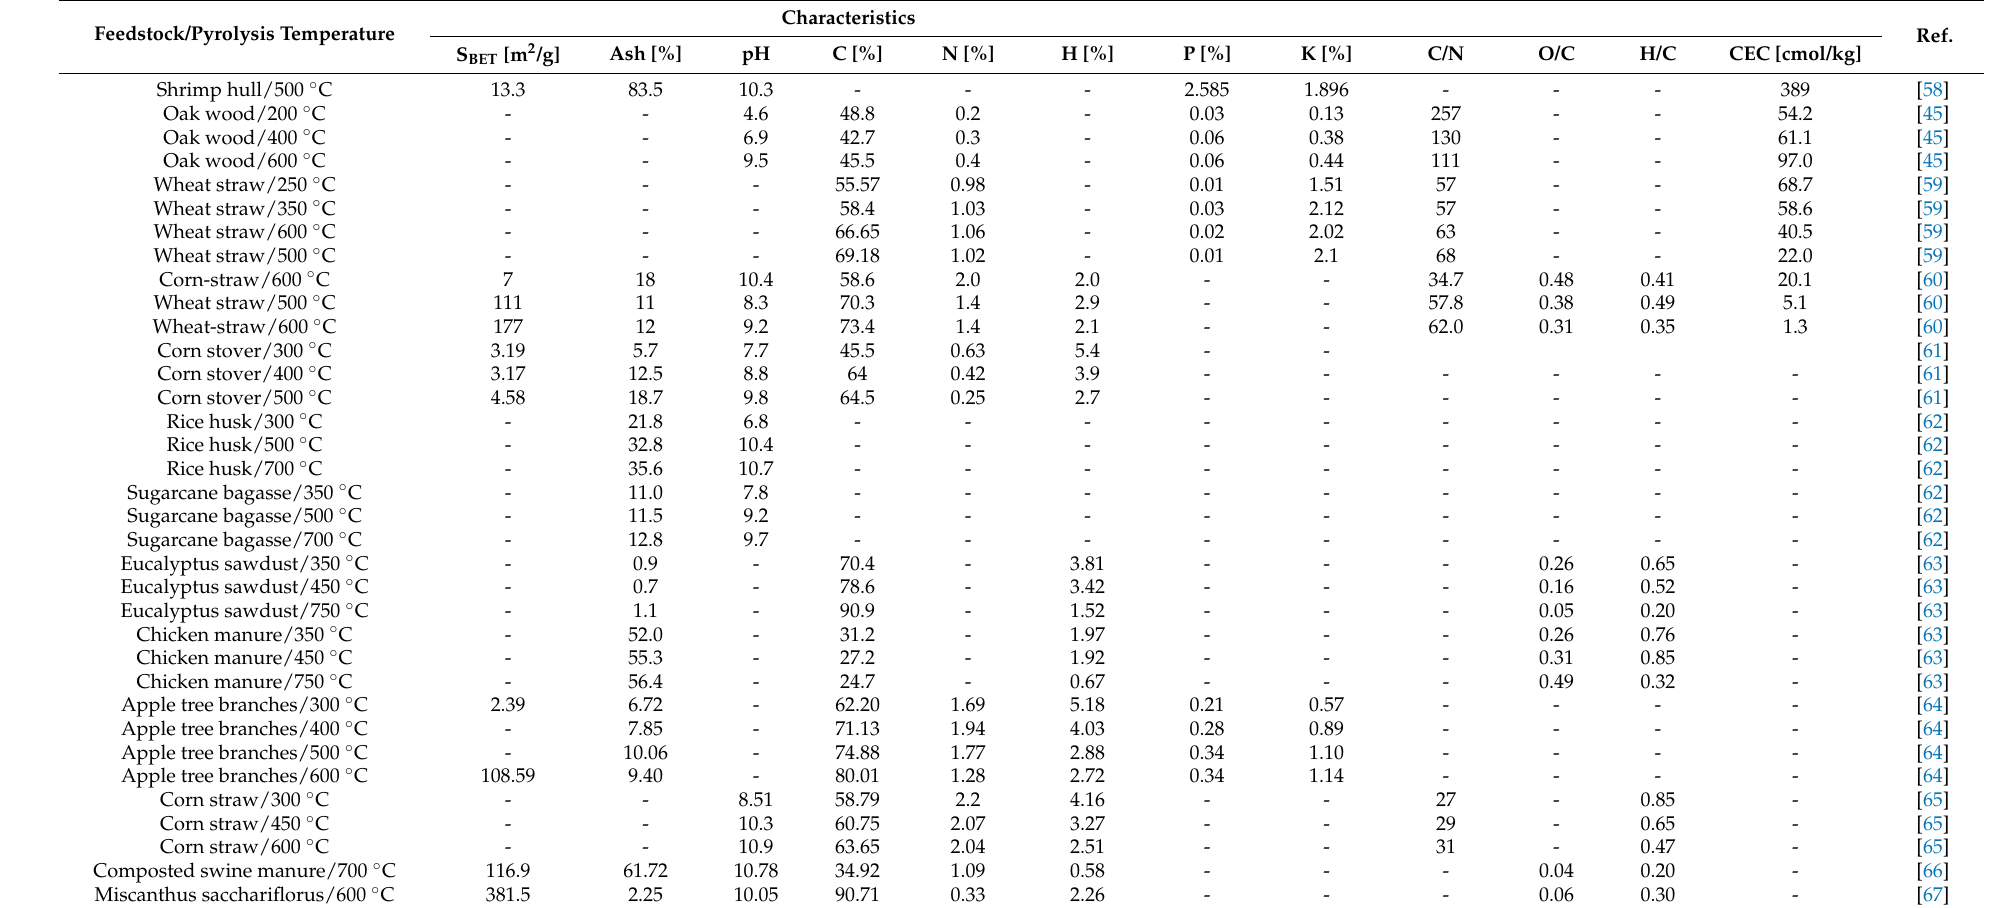
Table 1. Change in biochar characteristics as a result of different pyrolysis temperatures and types of